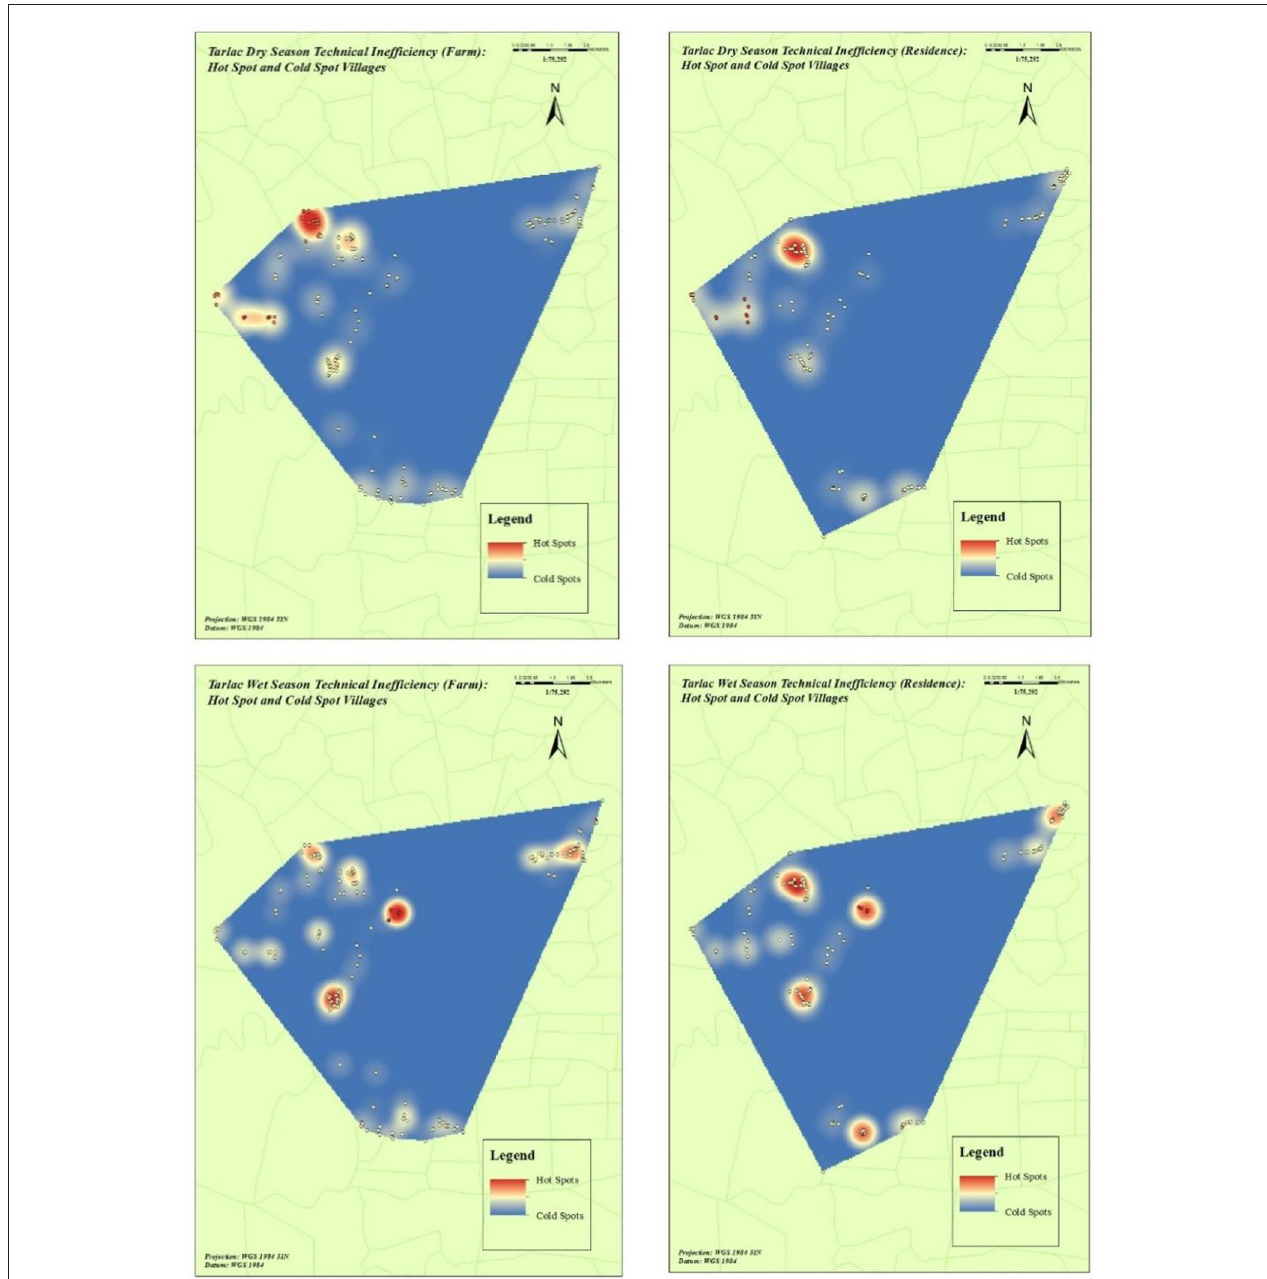
FIGURE 5 | Technical inefficiency hot spot and cold spot for farm areas (left) and dwelling places (right) in Tarlac for the dry (top) and wet (bottom) seasons. Note: The visual difference in the technical inefficiency hot spot maps in Tarlac according to geolocations and seasons is statistically not significant.